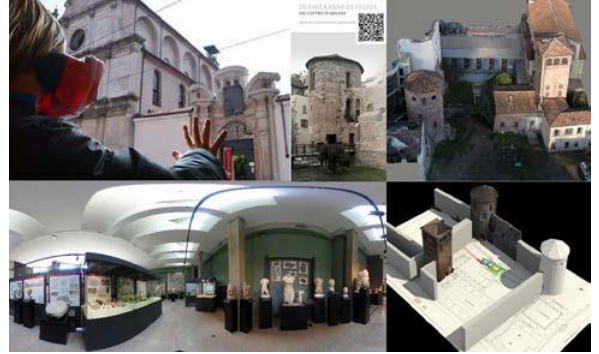
Figure 12.VR and 360° panoramic view and ETT